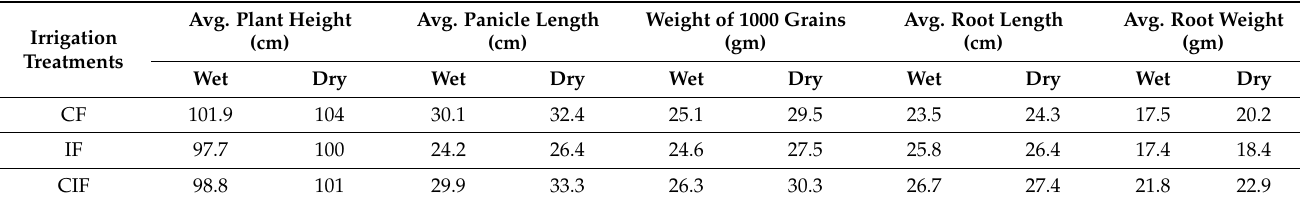
Figure 8. The seasonal emission of GHGs from the proposed rice fields by irrigation (CF, IF and CIF) and fertilizer treatments (FA-1, FA-2 and FA-3). Table 2. The estimated seasonal plant properties of proposed rice